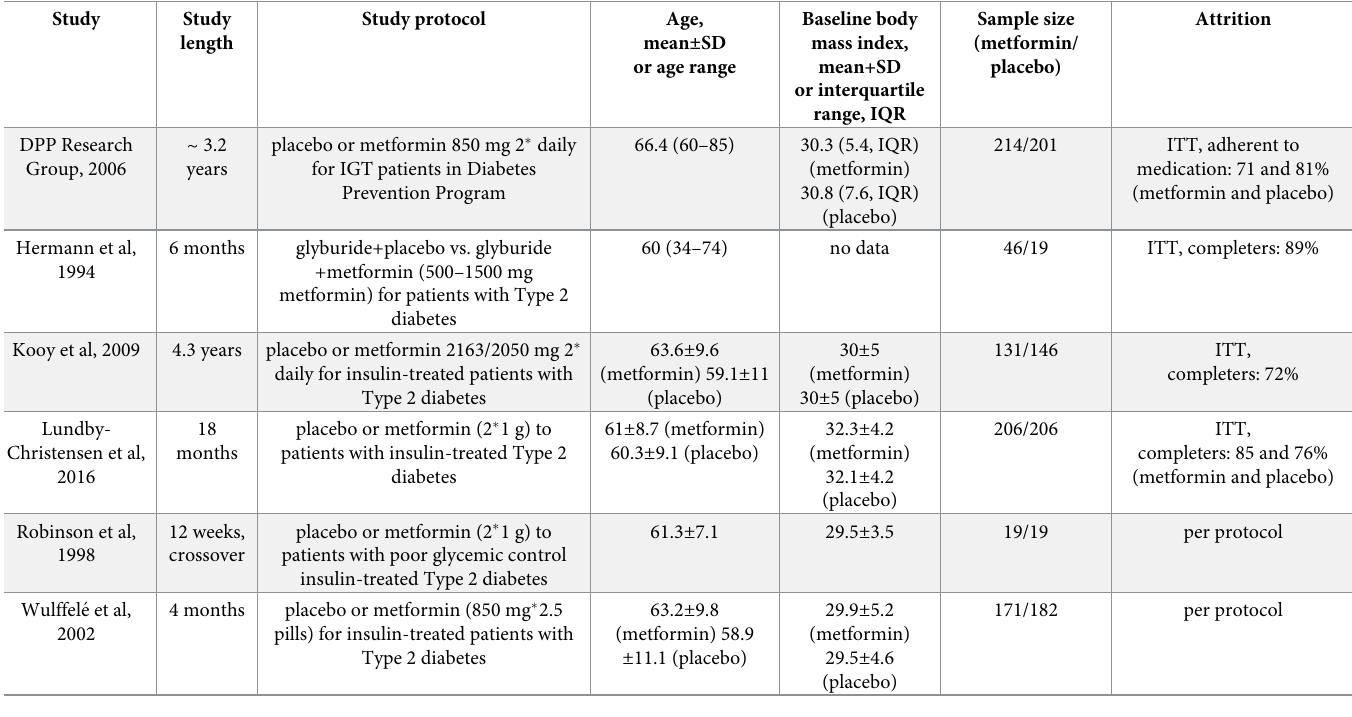
Table 1. Summary characteristics of the studies included in the